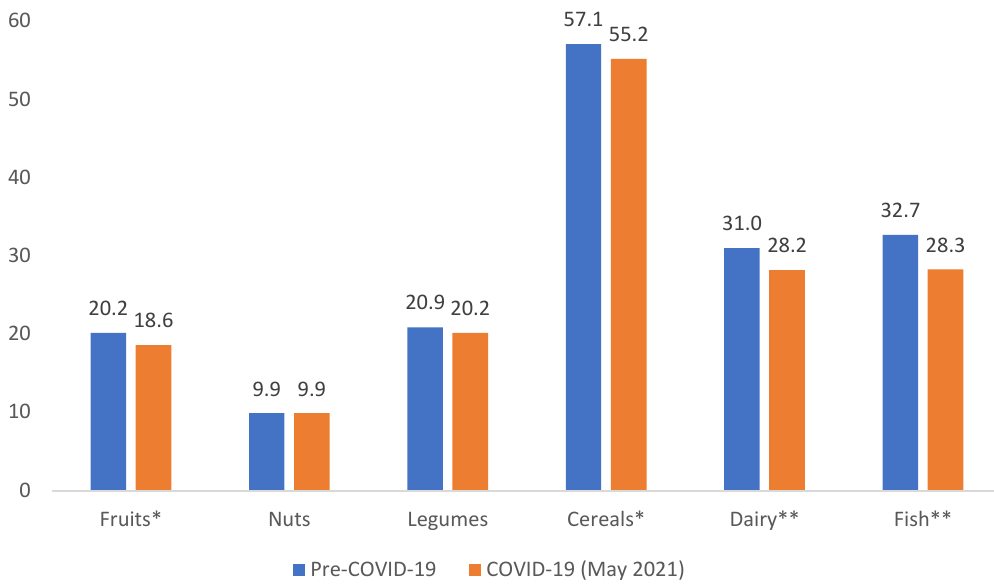
Figure 1. Compliance with the national dietary guideline components in the pre-COVID-19 period and the COVID-19 period (May 2021) according to the components among university students ( n = 3508). * p < 0.05,** p < 0.001.